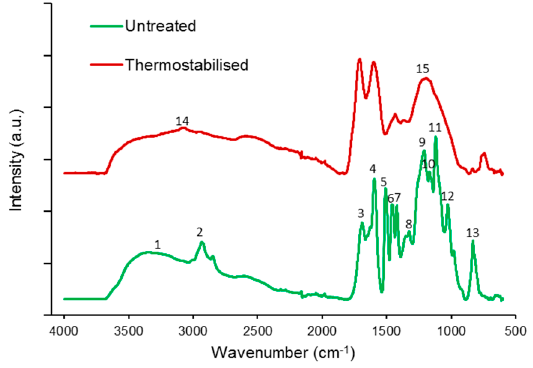
Figure 4. FTIR spectra of organosolv lignin particles before and after thermostabilisation.